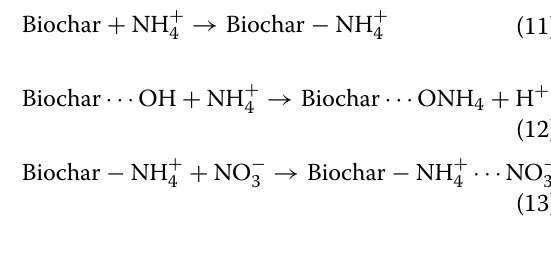
Table 4 Thermodynamic parameters of NH Parameter